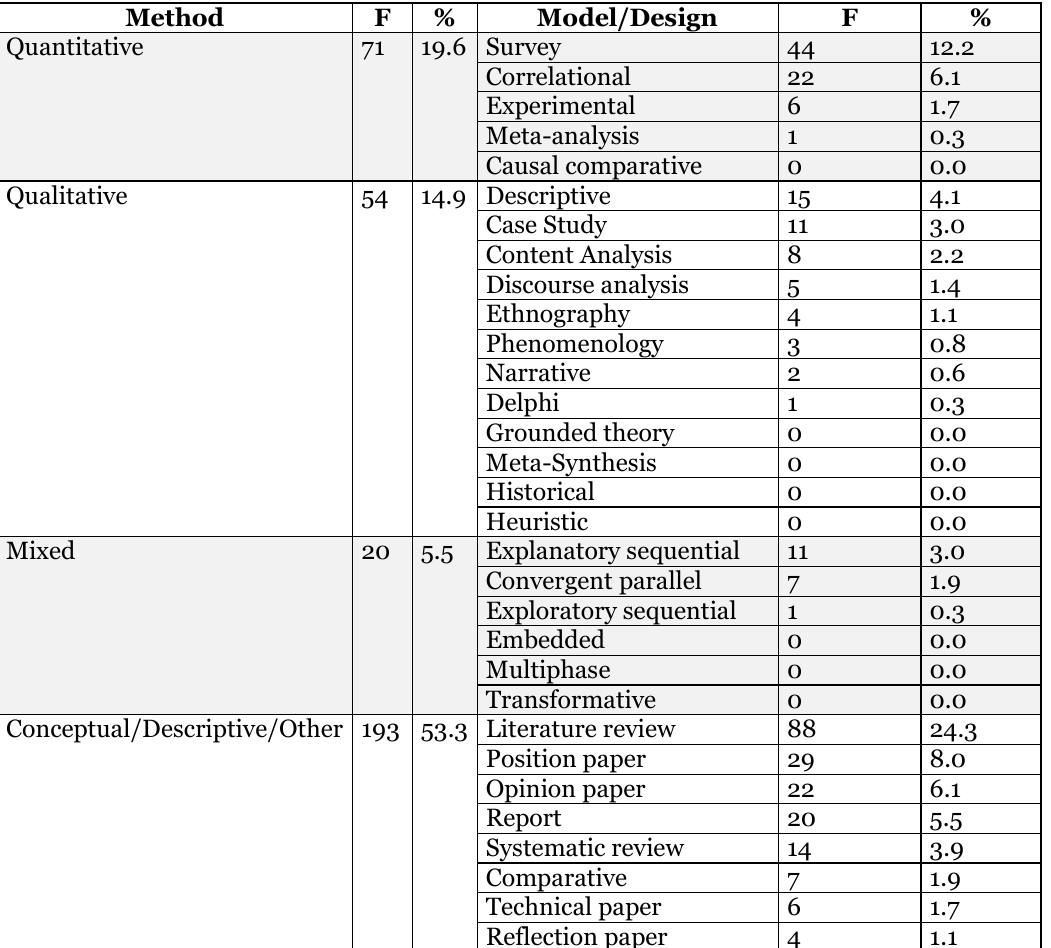
Description of Research Methodologies and Models/Designs (n=362)